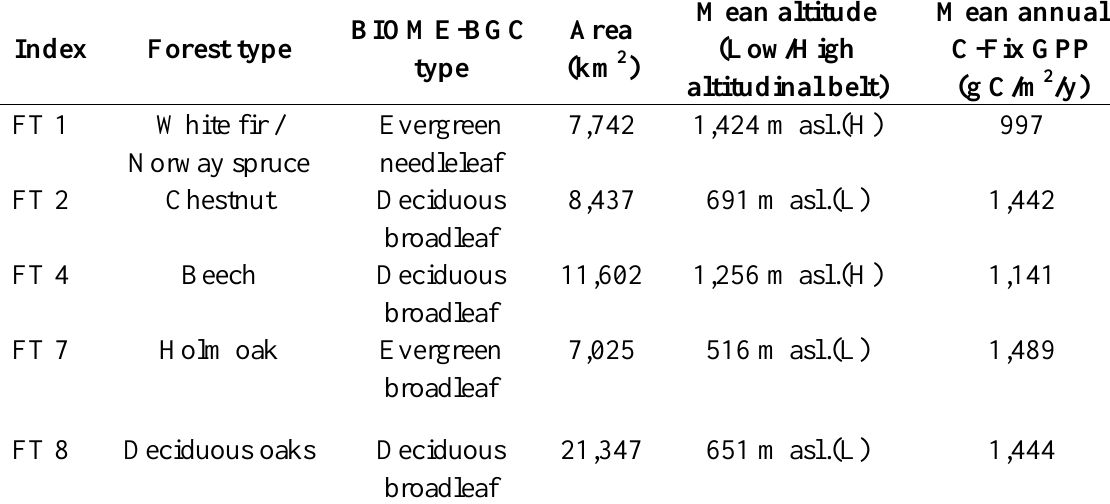
Table 1. Main characteristics of the forest types examined. The annual average GPP refers to the 10-year study period used as baseline (1999–2008).